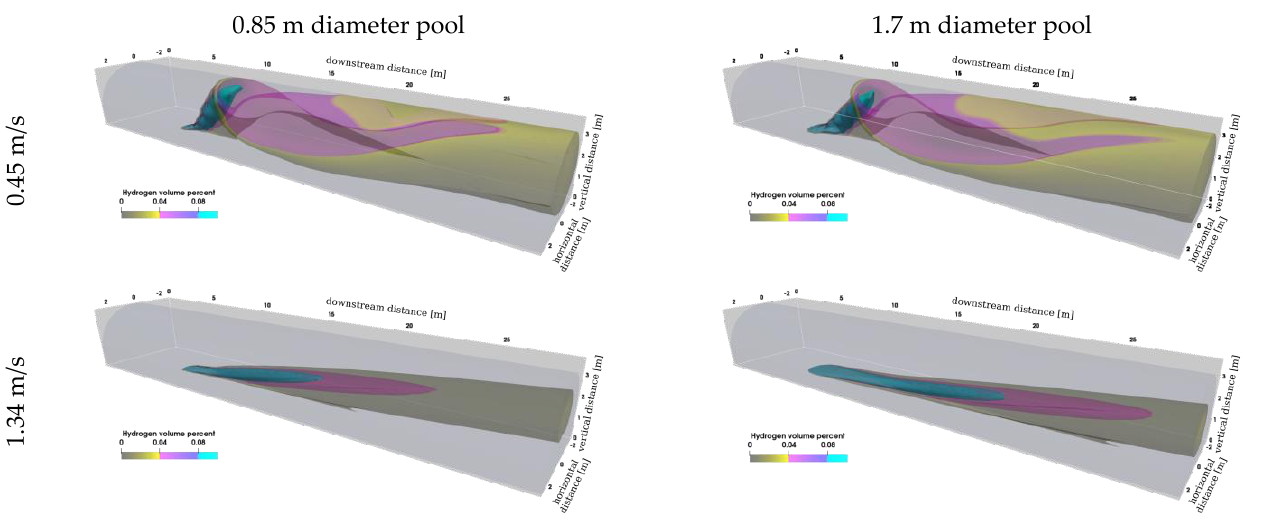
Figure 4. Isovolume contours of 4% and 8% mole fractions for the 0.85 m ( left ) and 1.7 m diameter pool ( right ) with 0.45 m/s ( top ) and 1.34 m/s ( bottom ) crosswinds.